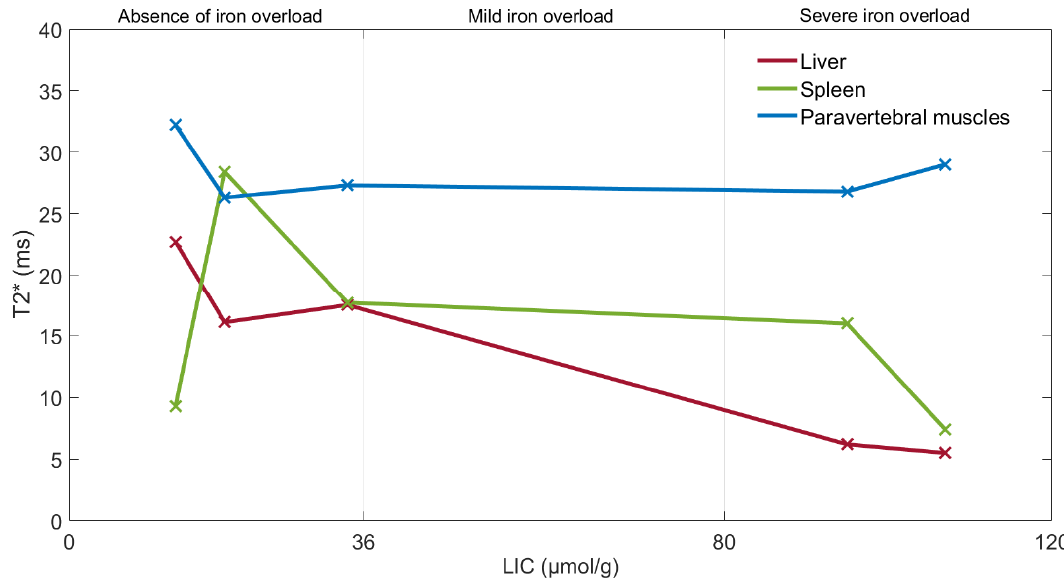
Figure 10. Relationship between the T2 * values of the liver, spleen and paravertebral muscles in absence of iron overload at 3T (13 µ mol/g and 19 µ mol/g) and at 1.5T (34 µ mol/g) and severe iron overload at 1.5T (95 µ mol/g and 107 µ